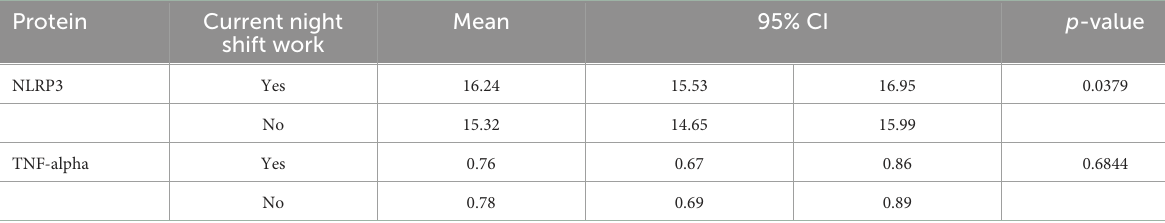
TABLE 2 Association between NS work and NLRP3 and TNF alpha.